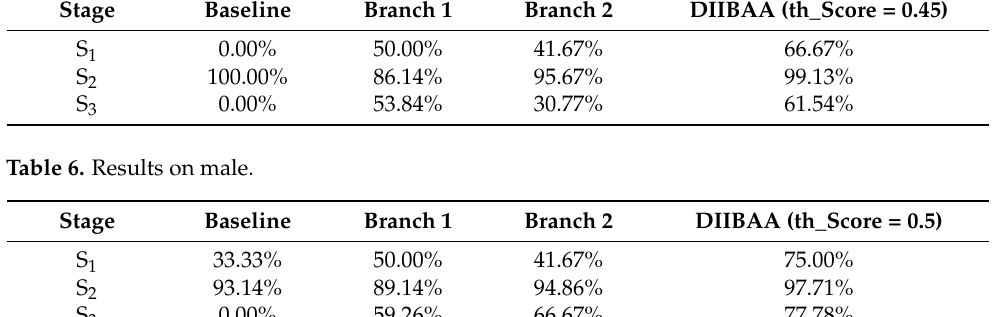
Table 1. The branch 1 column represents the results using three independent autoencoders